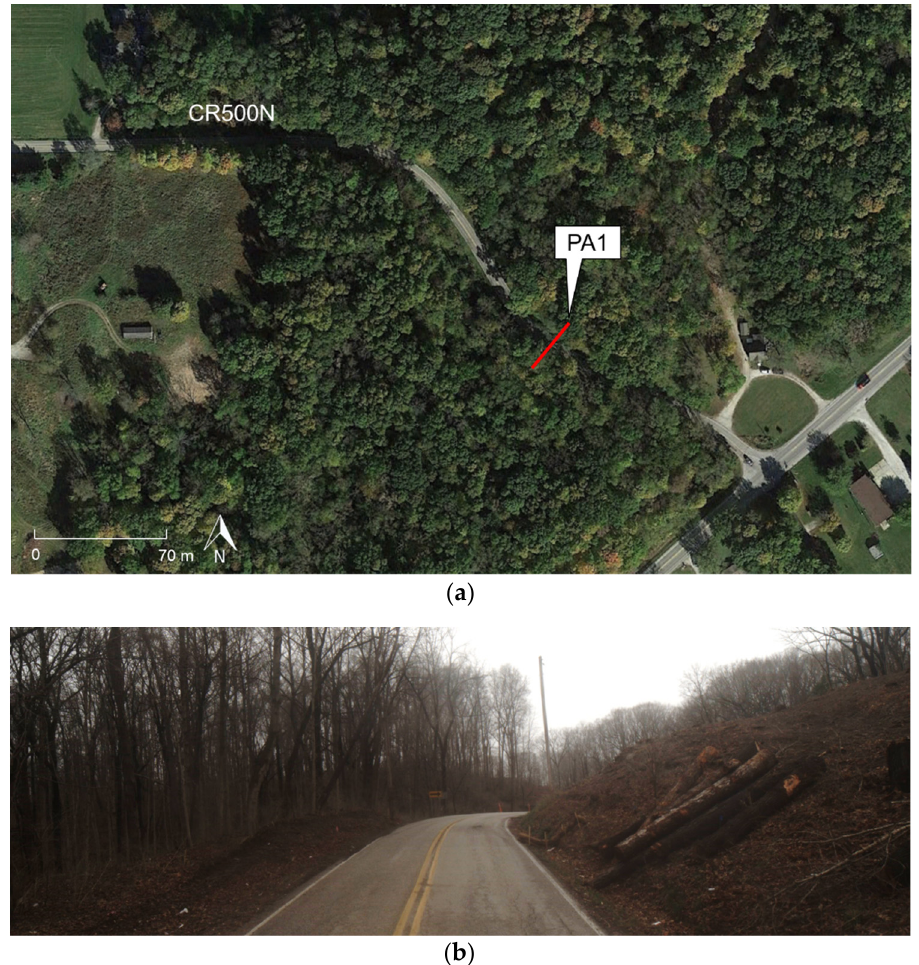
Figure 2. Study site at CR500N: ( a ) the surveyed area and cross-section location PA1 (aerial photo adapted from a Google Earth Image), and ( b ) image of the surveyed area at location PA1 captured by one of the cameras onboard the PWMMS-HA. Datasets C-1 and C-2 were collected over a state road, SR28, in Indiana, USA, with a total length of approximately 13 miles. The roadside ditches are present on both sides of the road and are covered by short vegetation and shrubs. A one-mile-long segment was selected as the ROI. Figure 4a shows an aerial photo of the ROI where PC1 , PC2 , PC3 , and PC4 are four cross-section locations that are used in the ditch line characterization analysis (as will be discussed later in Section 5.3). Figure 4b is an image capturing location